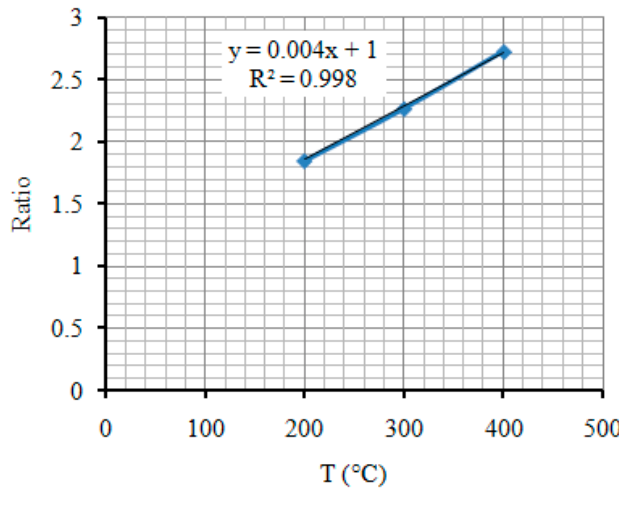
Figure 9. Equation and graph of f(T).